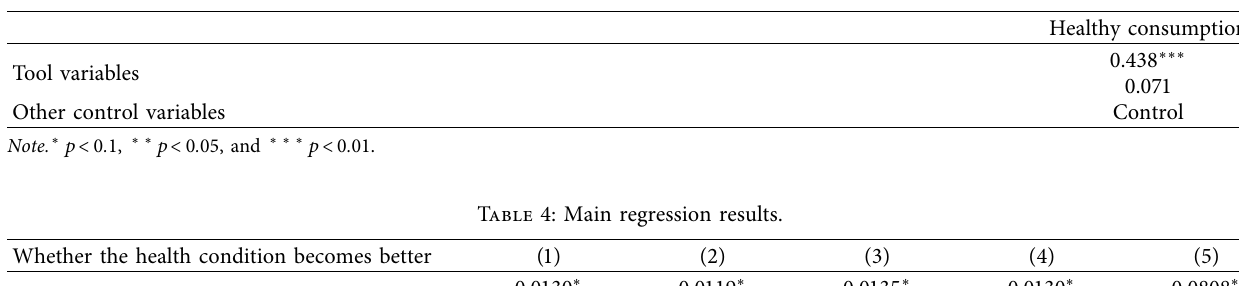
Table 3: One-stage regression results for instrumental variables.